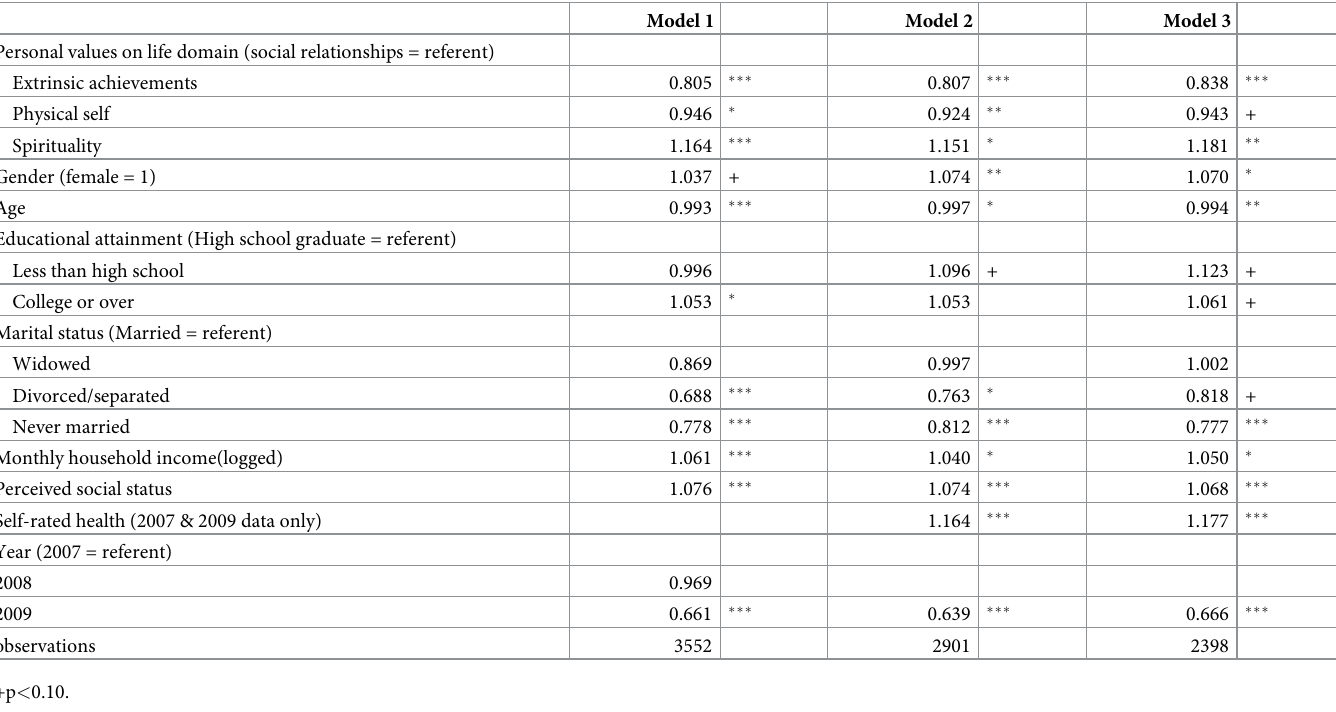
Table 4. Poisson regression analyses with robust error variances with age restriction (excluding respondents aged 60 years or older) and/or controlling for self- rated health in 2007 and 2009 surveys (relative